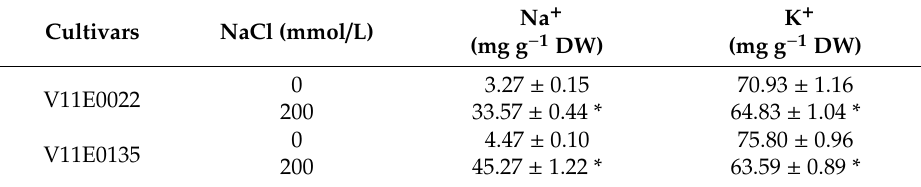
Table 2. E ff ect of salt stress on ionic content in two cultivars of the water dropwort. Table 2. Effect of salt stress on ionic content in two cultivars of the water dropwort.